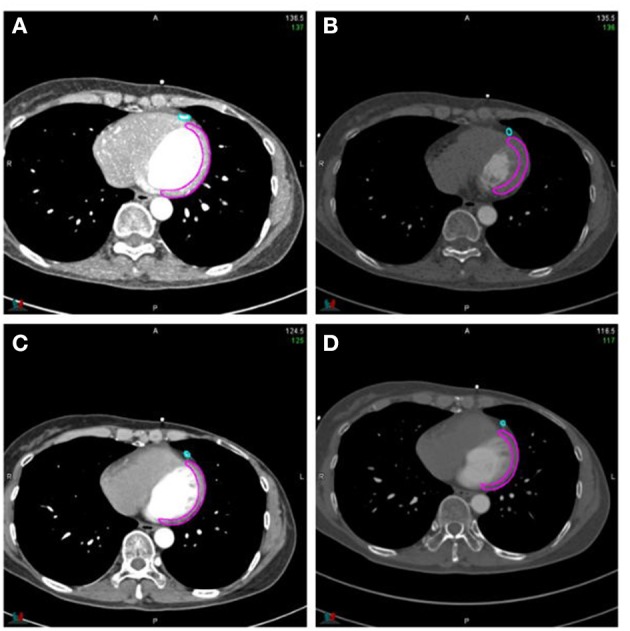
Reconstruction sketch. (A) MIP; (B) MinIP; (C) AIP; (D) SIP.